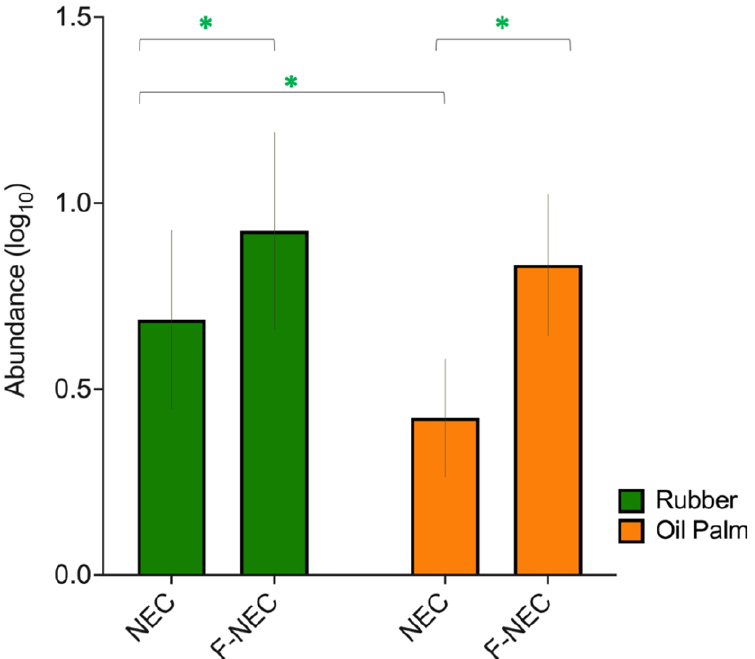
Figure 6. Comparison of captured rate (log 10 ) of two fruit bat guilds between (NEC: nectarivorous, F-NEC: frugi-nectarivorous) rubber plantation and oil palm plantation. The * indicates significance at p < 0.05.